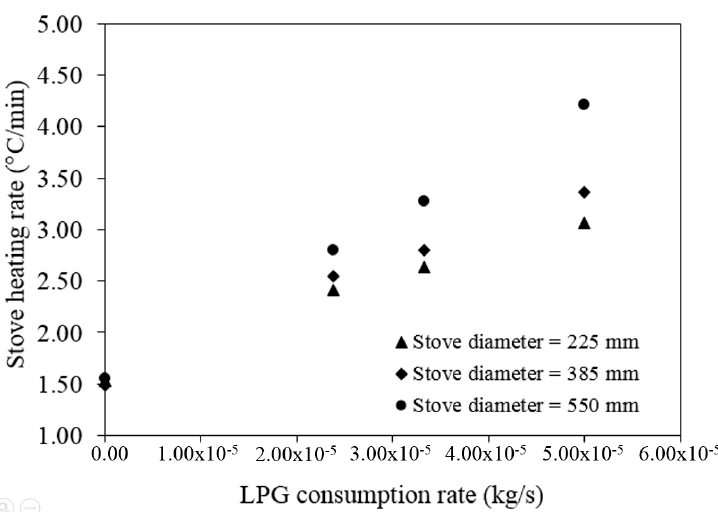
Figure 3. Relationship between stove heating rate and liquid petroleum gas (LPG) flow rate.